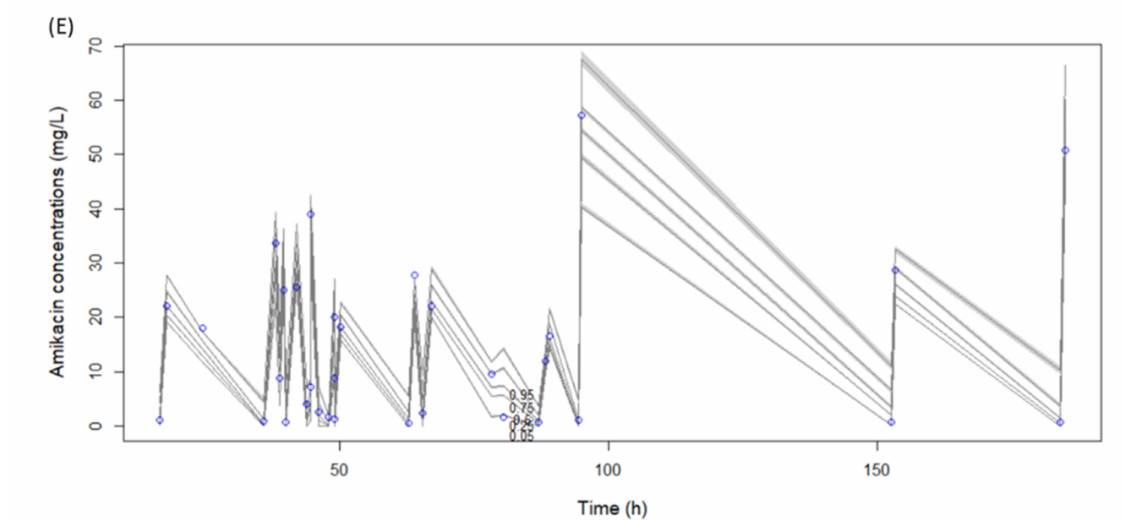
Figure 1. Diagnostic plots for the final covariate model. ( A ) Observed vs. individual posterior predicted amikacin concentrations and ( B ) observed vs. population predicted amikacin concentrations in plasma. The solid lines represent the line of best fit (regression line). CI, confidence interval; Inter, intercept. ( C ) Weighted residuals errors vs. observation concentrations and ( D ) weighted residuals errors vs. time after dose (TAD). ( E ) Observed amikacin concentration time data and visual predictive check of the final model. The lines represent concentrations at the designated quantile given by the number on the line (0.0.5, 0.25, 0.5. 0.75, and 0.95). The circles represent observed patient amikacin concentrations.